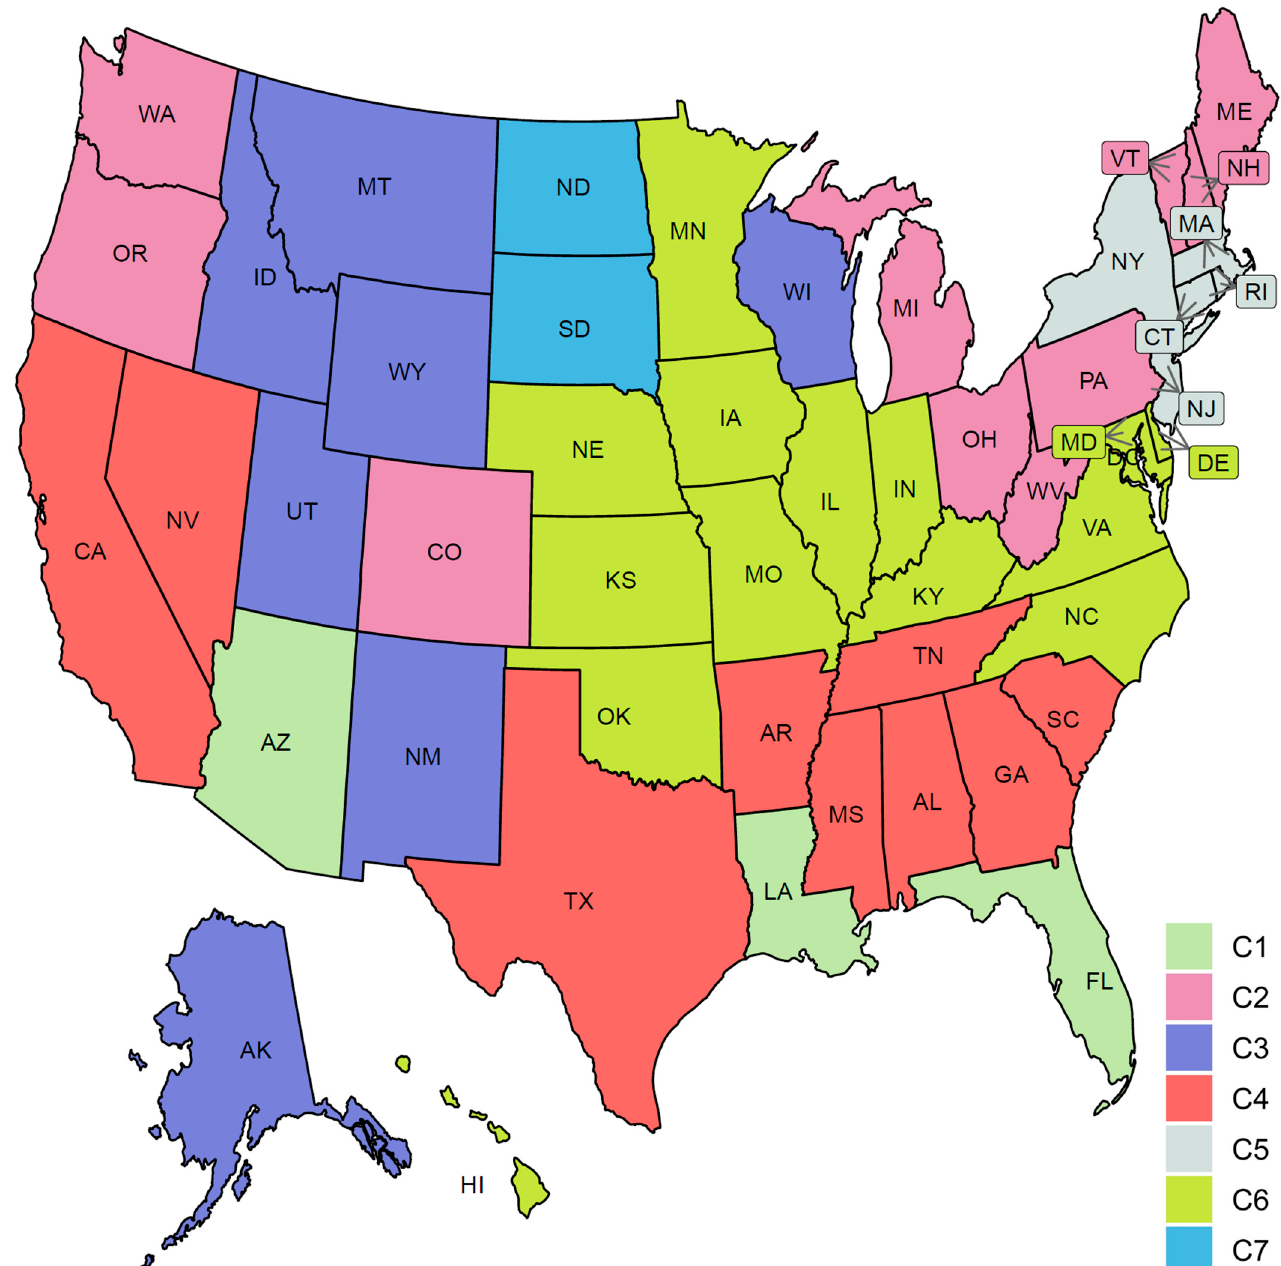
Figure 9. Clustering result of the 51 states based on the COVID-19 confirmed case trajectories. States assigned to the same cluster share the same color.